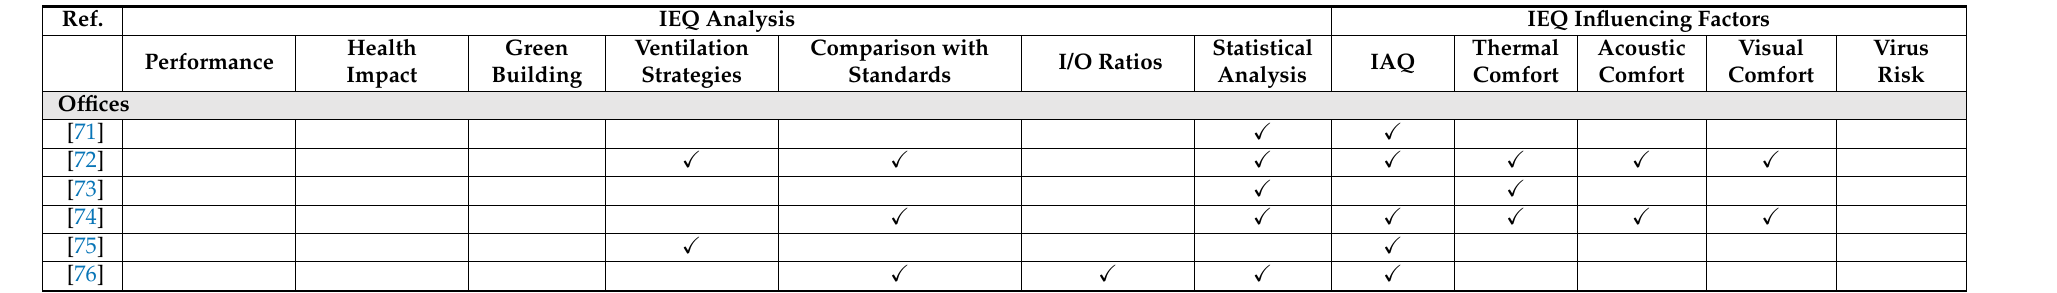
Table A3. IEQ Analysis and Influencing